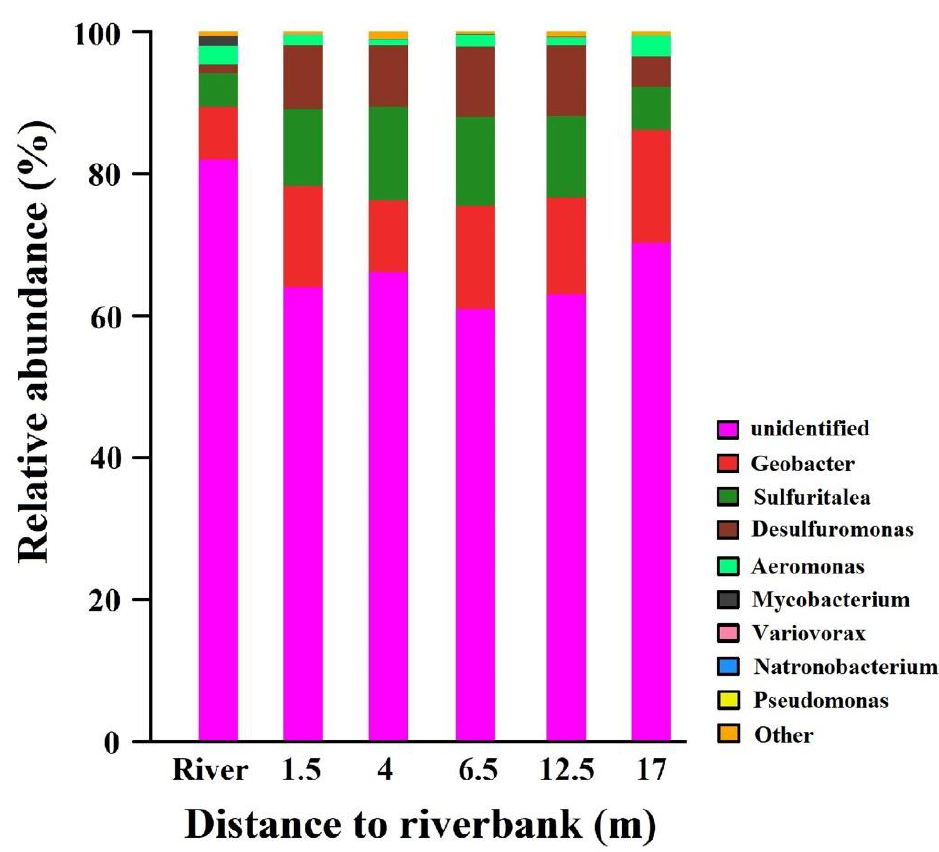
Figure 8. Species composition containing the As(V)-reducing gene arr A in genus-level (Other: the summation of the bacteria, of which the relative abundance was considerably below 1%).